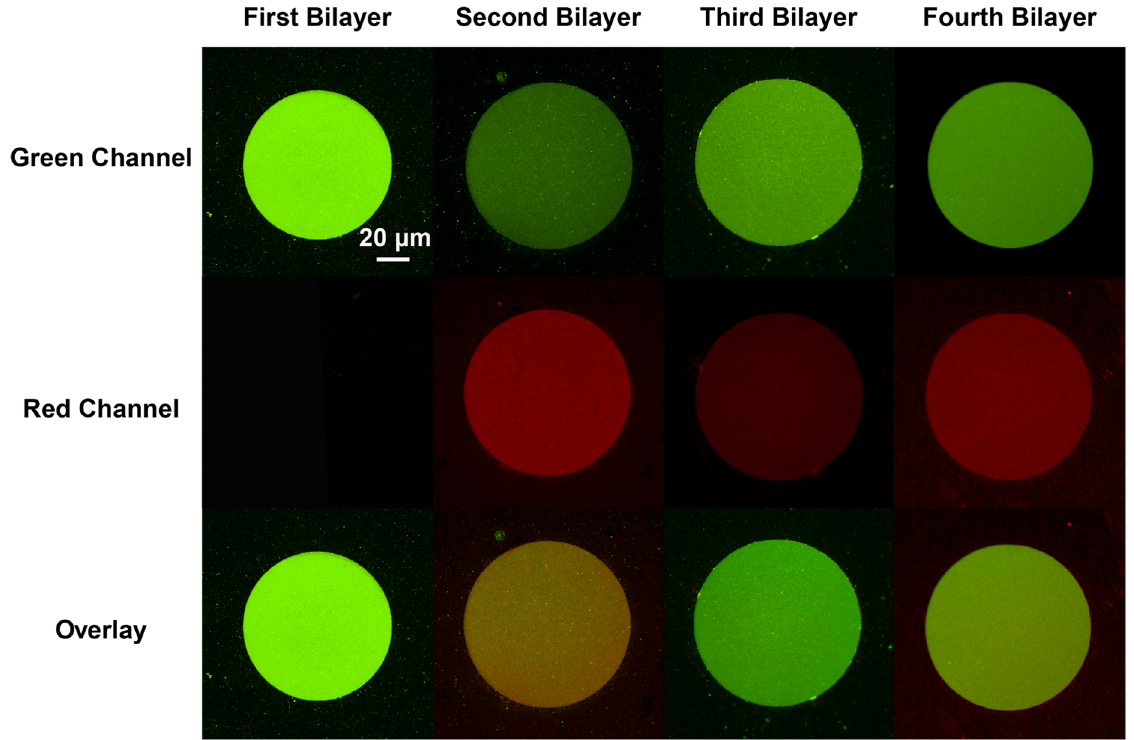
Figure 2 . Epifluorescence images of four-bilayer homogeneous stacked SLB